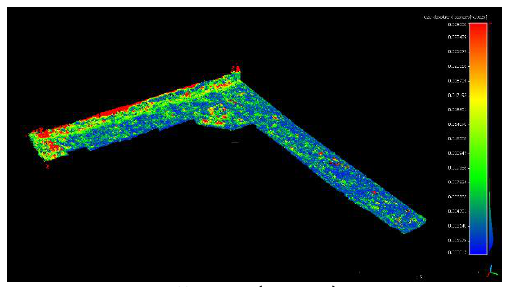
Figure 13. Slight difference (1-3 mm) between UAV and LiDAR clouds on the terracotta